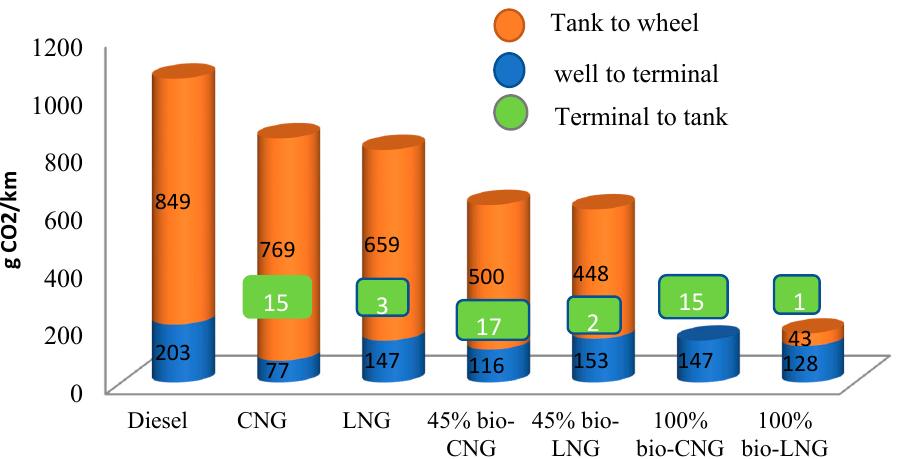
Figure 4. Wheel to Wheel emissions of heavy goods vehicles, adapted from [57].